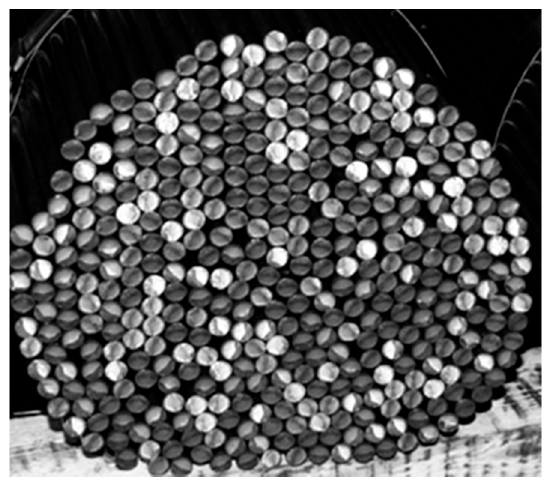
Figure 1. A view of a bar bundle prepared for heat treatment, which shows the cellular structure of the charge.